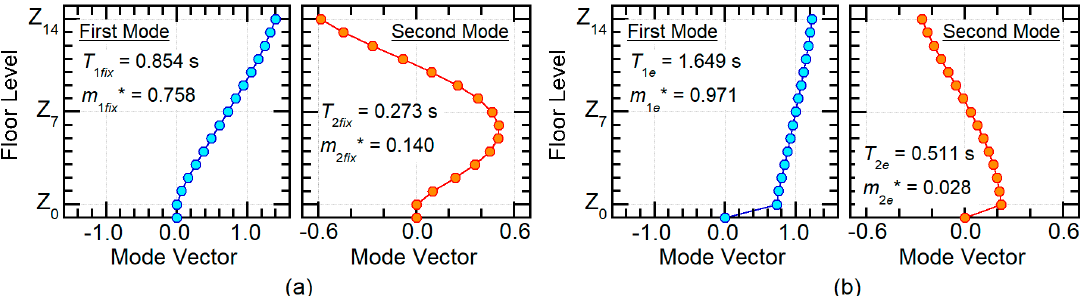
Figure 6. Shapes of the first and second natural mode vectors of the building models in the elastic range: ( a ) non-base-isolated; ( b ) base-isolated.